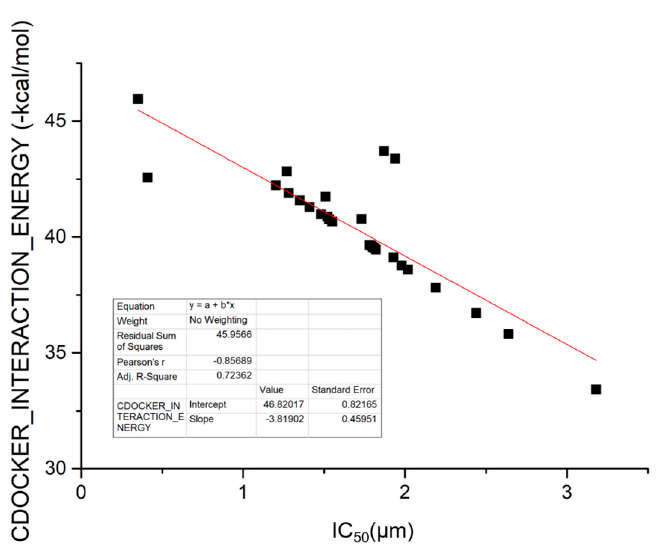
Figure 7. The fitting correlation between the binding energy and COX-2 inhibition. Molecules 2019 , 24 , x FOR PEER REVIEW